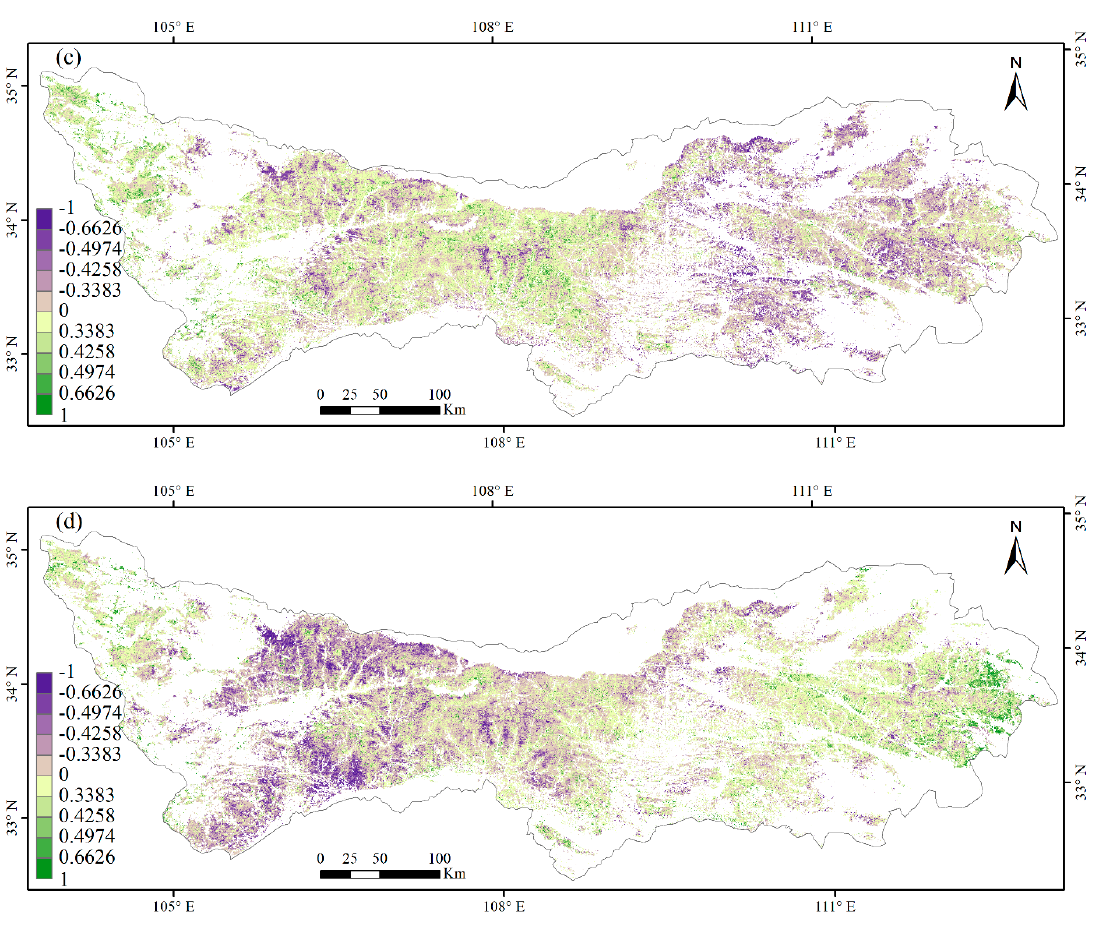
Figure 7. Spatial patterns of partial correlation coefficients between the SOS (EOS) and preseason mean temperature and accumulated precipitations in the QMs during 2001–2017: ( a ) partial correlation coefficients between SOS and preseason mean temperatures, controlling for corresponding EOS and accumulated precipitation; ( b ) partial correlation coefficients between the SOS and preseason accumulated precipitation, controlling for corresponding EOS and mean temperature; ( c ) partial correlation coefficients between EOS and preseason mean temperatures, controlling for corresponding SOS and accumulated precipitation; ( d ) partial correlation coefficients between EOS and the preseason accumulated precipitation, controlling for corresponding SOS and mean temperatures. The color-coded values of ±0.6226, ±0.4974, ±0.4258, and ±0.3383 correspond to p - values of 0.01, 0.05, 0.10, and 0.20, respectively, according to two-tailed Student’s t -tests.